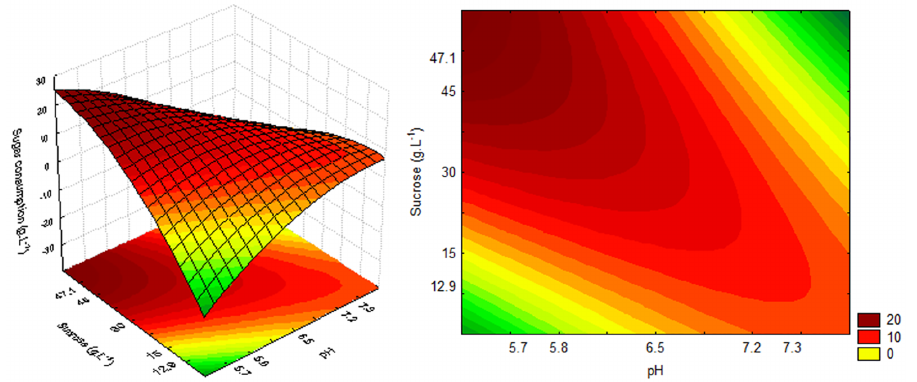
Fig 4. Response and contour surfacesas a function of sucrose concentration and pH for sugar